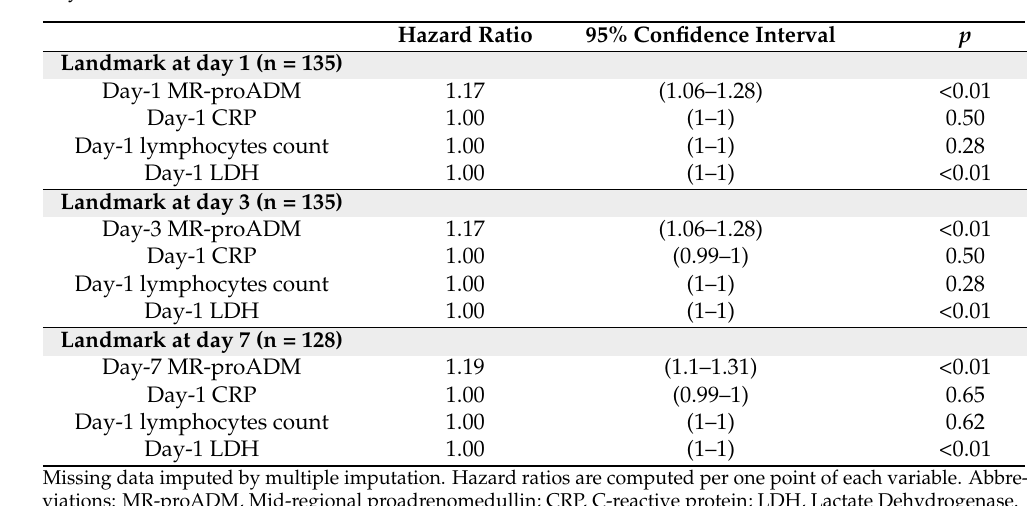
Figure 3. ROC curves of the association of day-60 mortality with various biomarkers on day 1 and the SOFA score. Abbreviations: MR-proADM, Mid-regional proadrenomedullin; SOFA, Sequential Organ Failure Assessment; CRP, C-reactive protein. Table 2. Adjusted landmark analysis of the association of MR-proADM with day-60 mortality on days 1, 3, and 7.